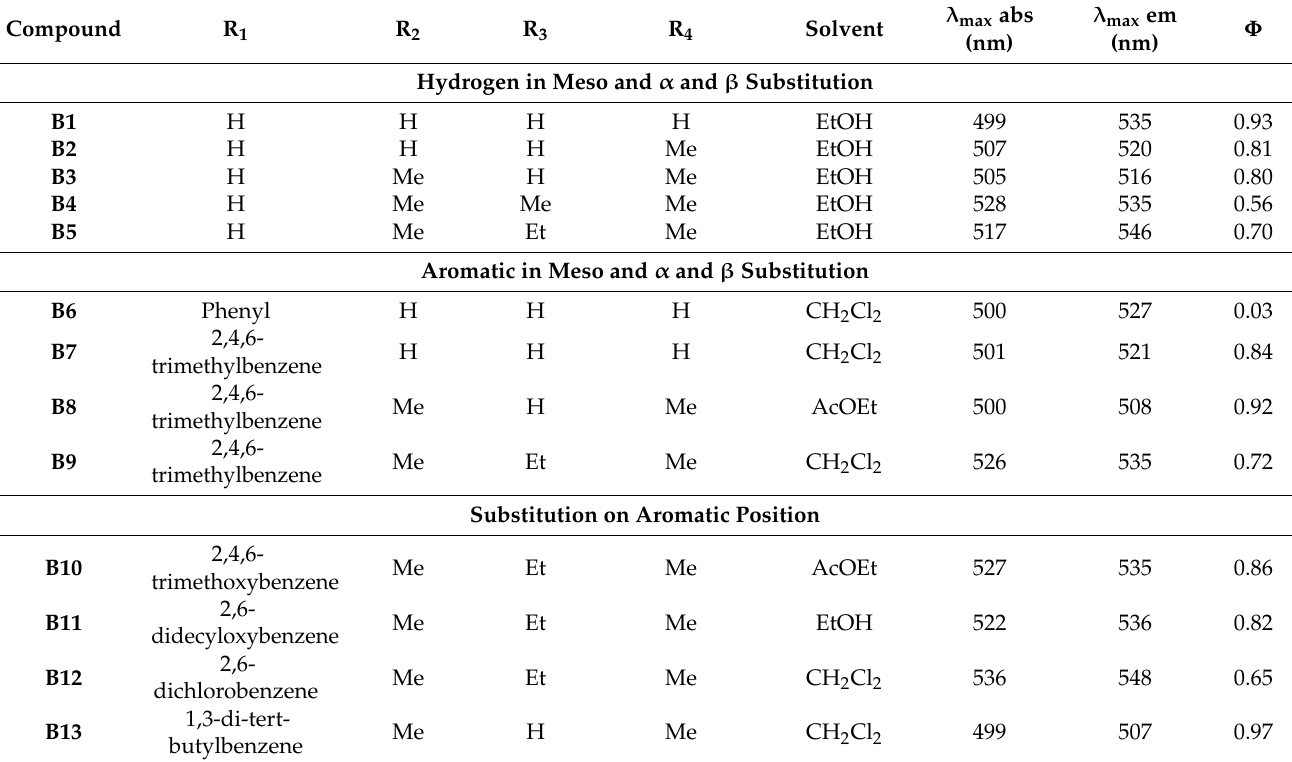
Table 1. Investigated BODIPYs structures and experimental parameters ( λ max abs, λ max em and Φ ) from ref [50].